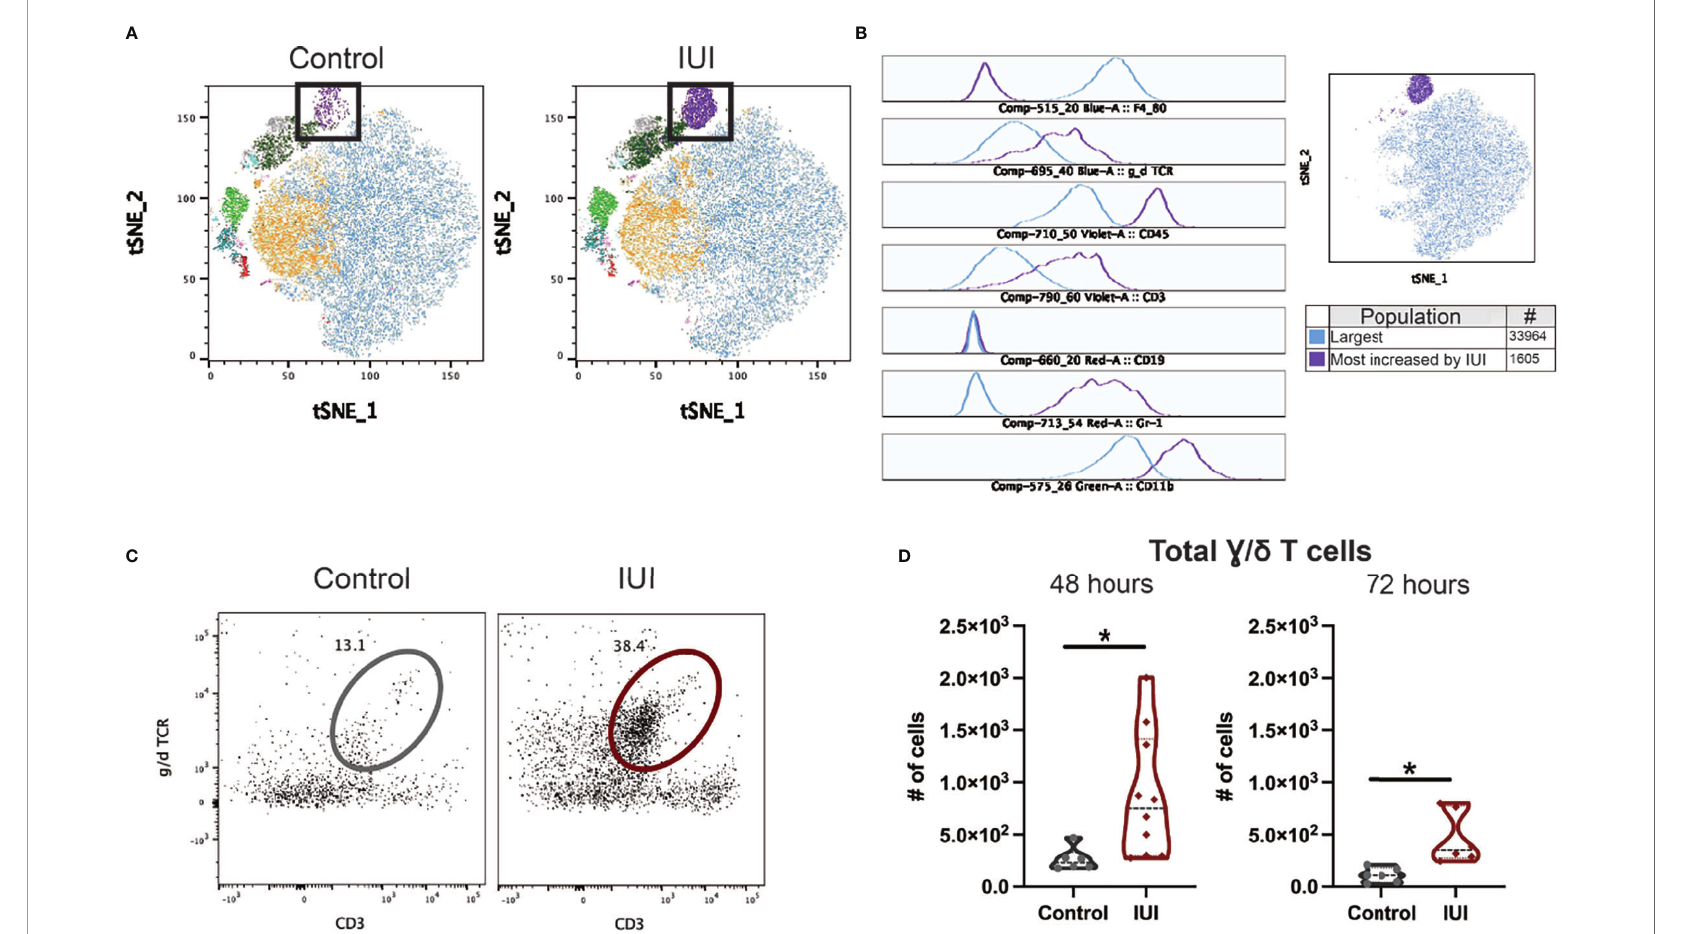
FIGURE 6 | Intrauterine in fl ammation increases g / d T cells in the fetal brain. Fetal brains were collected at 48 and 72 hours post-uterine injection and processed for fl ow cytometry. CD45+ cells in the fetal brain at 72 hours were analyzed by FlowJo plug-ins tSNE and fl owSOM to visualize and identify clusters, respectively. (A) Fetal brain CD45+ cells from saline-control and IUI-exposed dams were visualized by tSNE and colored by fl owSOM populations. Black box indicates the most increased population by IUI. (B) Histograms of marker expression for two populations identi fi ed by fl owSOM: the largest population (blue) and the population most increased by IUI-exposure (purple). (C) Representative fl ow plots of the g / d T cells in the fetal brain, gated on non-debris, singlet, live, CD45+, non-microglia, CD19- cells. (D) g / d T cells were counted in each fetal brain sample. All cell count data was analyzed by Shapiro-Wilk test to establish data distribution. Normally distributed data were analyzed by unpaired t-test and non-normally distributed data were analyzed by Mann-Whitney test. Normally distributed data with positive F-test for unequal variance were analyzed by unpaired t-test with Welch ’ s correction.